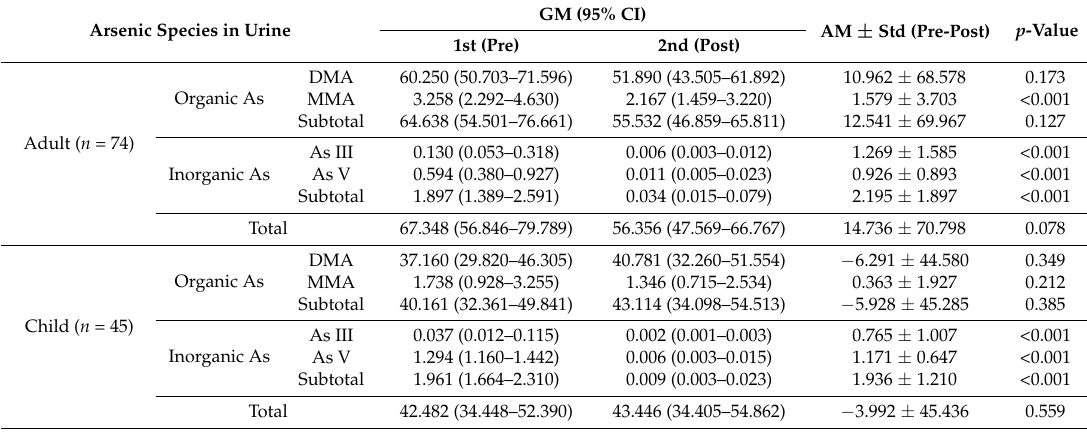
Table 4. Arsenic concentrations of the adult and child exposure groups at the first and second tests. Arsenic Species in